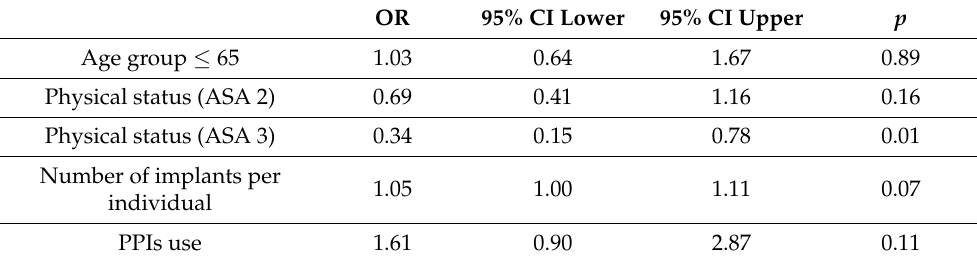
Table 4. Binary Logistic regression coefficients (at the patient level) to predict implant